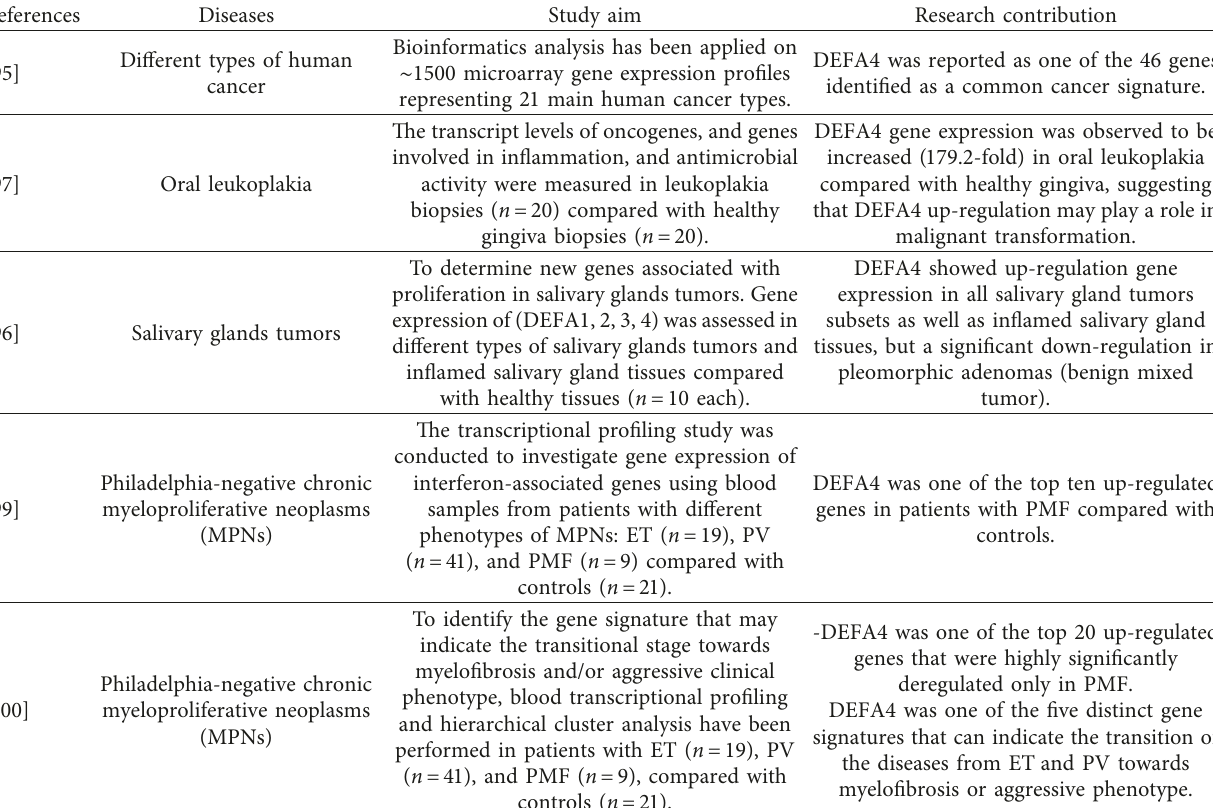
Table 3: List of studies that observed changes in DEFA4 gene expression in different cancer